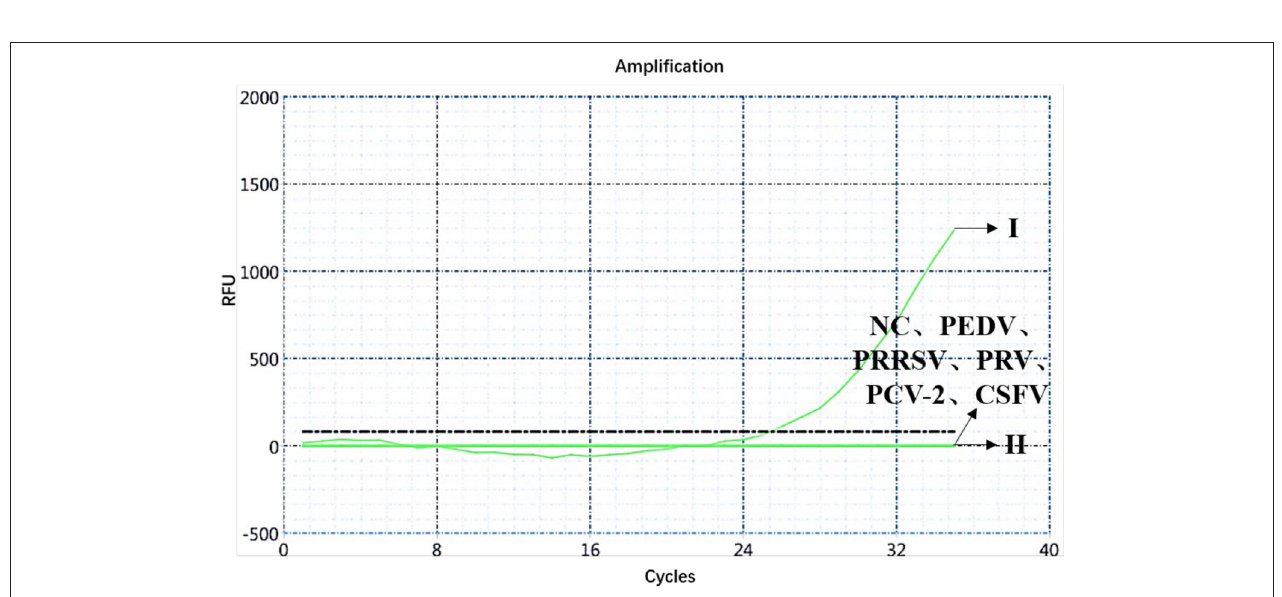
FIGURE 3 | Amplification curve for the FAM channel of ASFV genotypes I and II, PEDV, PRRSV, PRV, PCV-2, CSFV, and negative nucleic acid pig samples determined through dual real-time PCR.